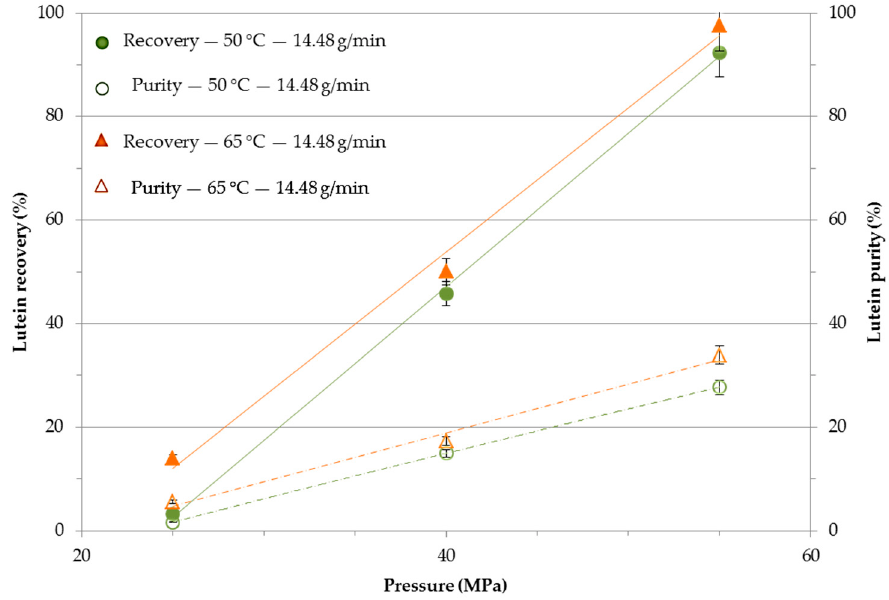
Figure 3. Influence of SF-CO 2 extraction temperature and pressure at CO 2 flow rate of 14.48 g/min on the recovery and purity of lutein.